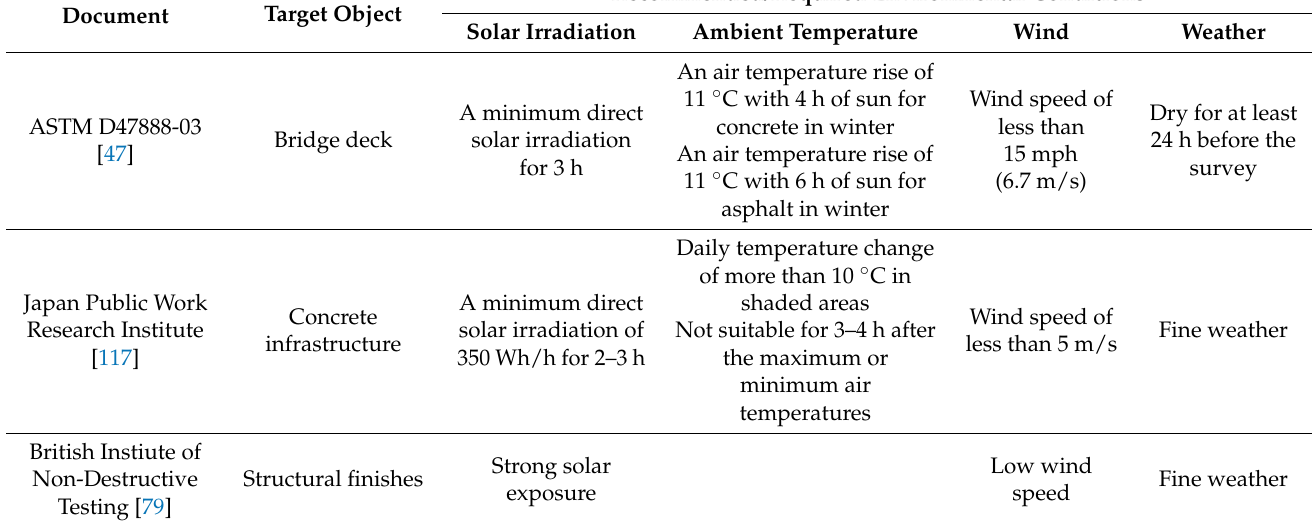
Table 1. Existing standards and guidelines of infrared thermography (IRT) for delamination detection and recommended/required environmental